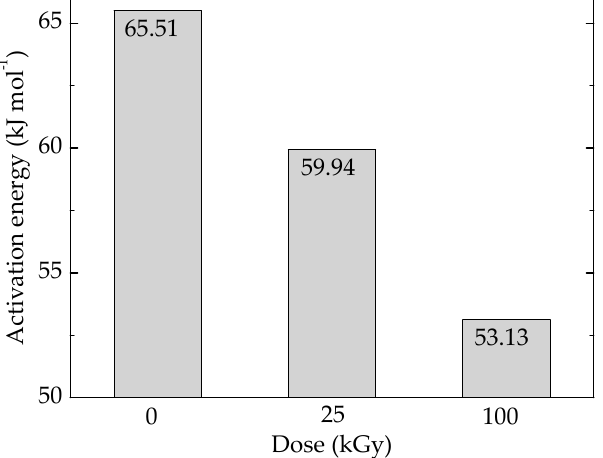
Figure 5. Activation energies values for the oxidation of pristine Ov-POSS.